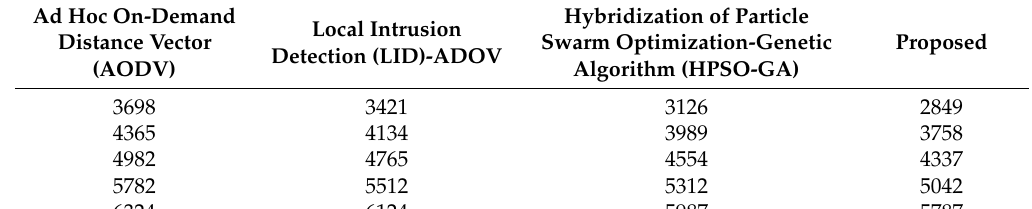
Figure 7. The routing overhead (bytes). Table 7. The routing overhead evaluation values.